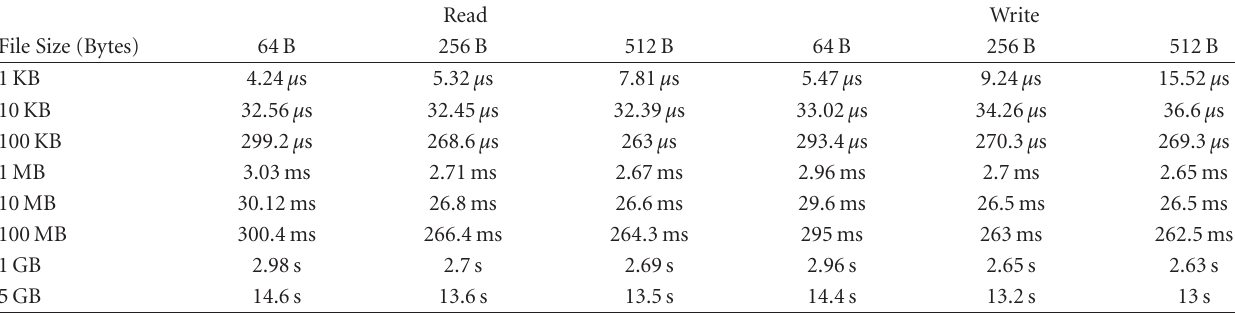
Table 1: HWFS sequential read/write execution time in simulation with di ff erent block sizes. Read Write